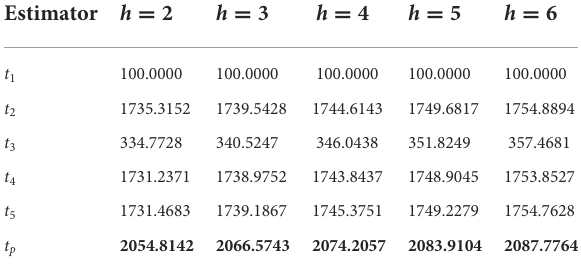
TABLE 4 PRE of different estimators with respect to t 1 for Population 3.